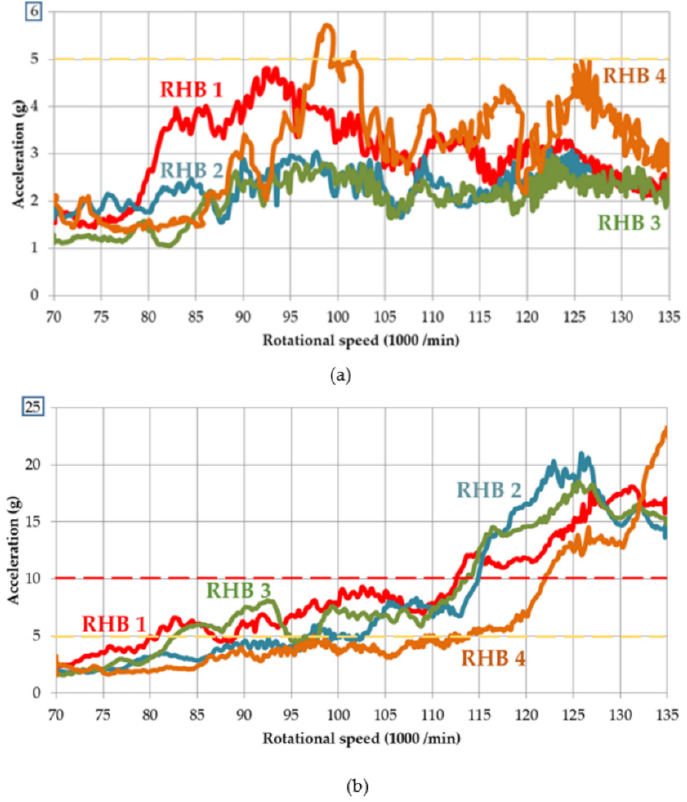
Figure 5. Vibration acceleration for RHBs 1–4: ( a ) excited up to 5 g; ( b ) excited above 10 g. In the area of safe operation (under the yellow dashed line, Figure 5a), RHBs 2 and 3